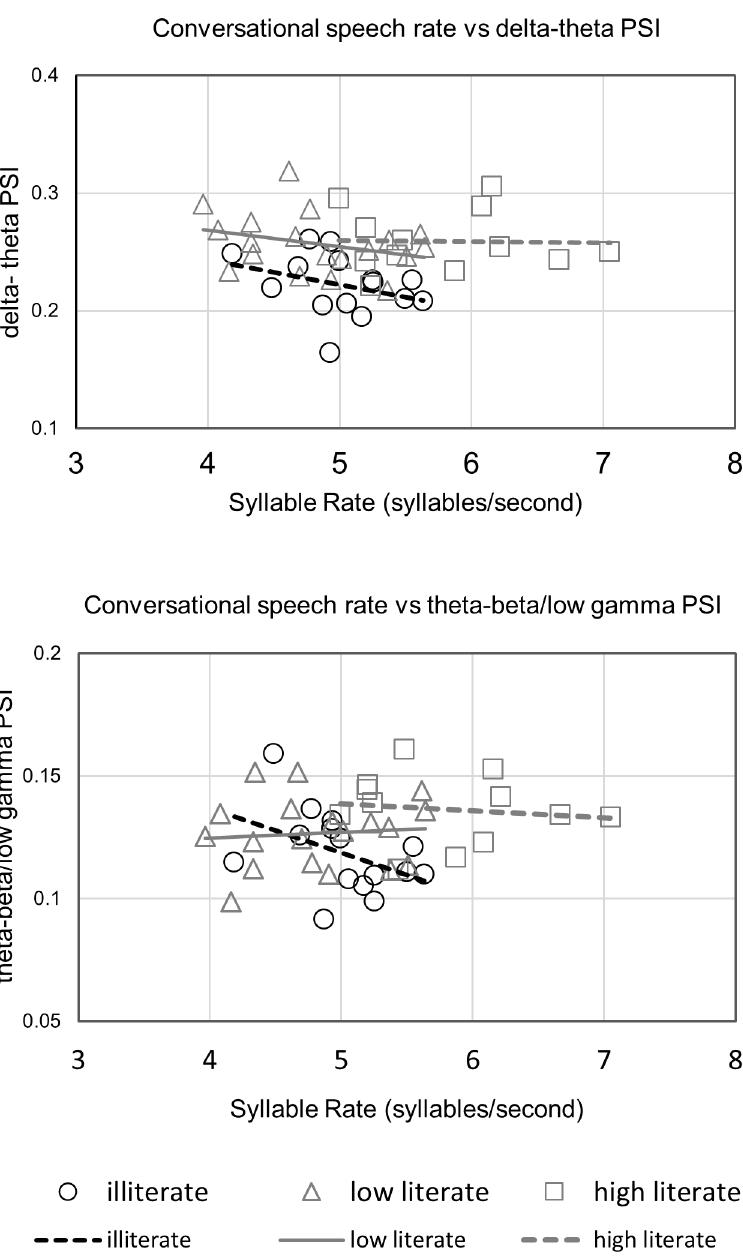
Fig 4. Participant mean conversational syllable rate (syllables per second) plotted against Phase Synchronization Index(PSI) values for delta-theta PSI (upper panel) and theta-beta/low gamma PSI (lower panel), with linear trend lines depicted. All correlations, p >